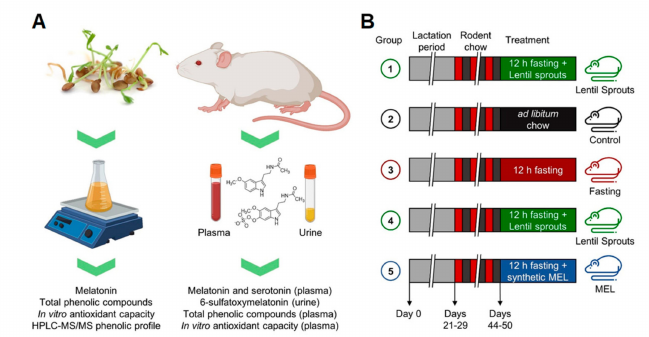
Figure 1. Schematic diagram of the experiments design of this research: ( A ) Lentils were germinated for six days, and phytochemicals (melatonin and phenolic compounds) were extracted and characterized, as was the in vitro antioxidant capacity of the product. Lentil sprouts were given to rats and plasma and urine were used for the measurement of melatonin, serotonin, 6-sulfatoxymelatonin (immunochemically), and phenolic compounds and the in vitro antioxidant capacity following the protocol here illustrated: ( B ) The first group of rats fasted for 12 h. They were then administered a lentil sprout extract via gavage followed sequential blood extraction for the pharmacokinetic study.